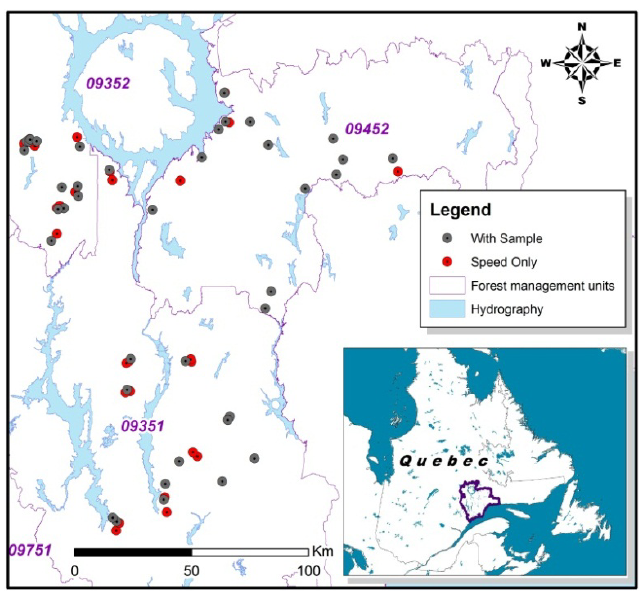
Figure 2. Location of sample plots in the North Shore region of Quebec,